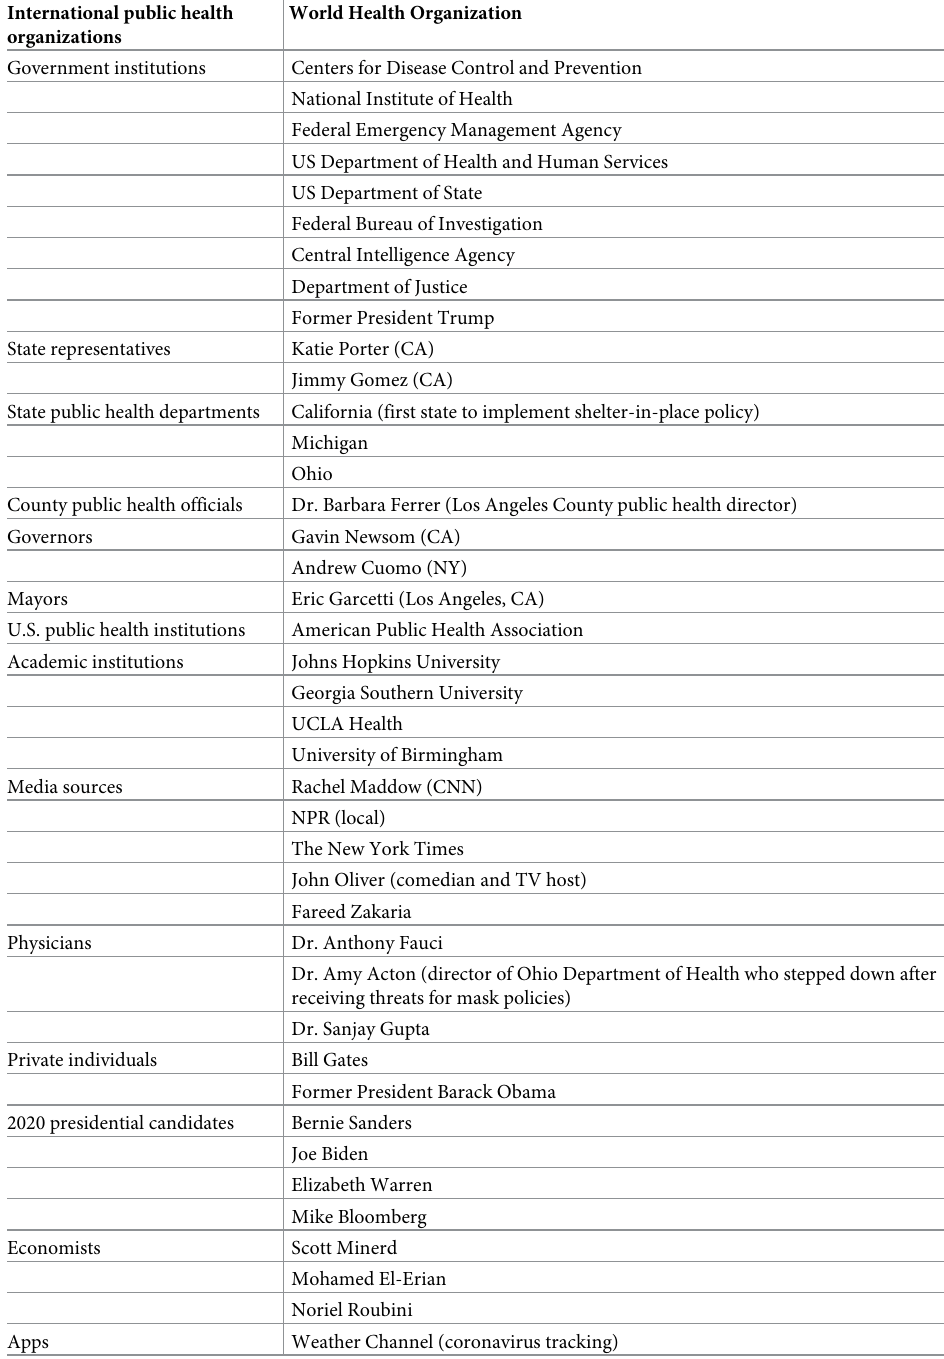
Table 1. Government, health, and other institutions mentioned (@) in mask